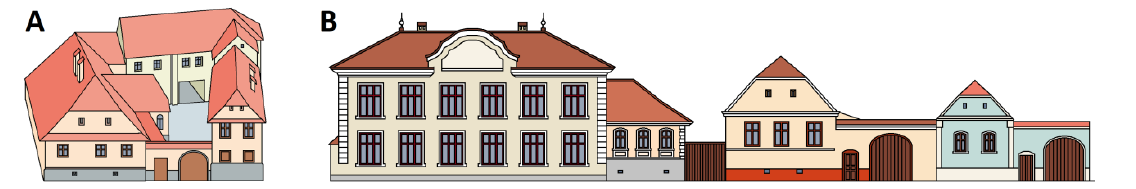
Figure 1: Typical historical buildings in the region of Rupea, A – Bird's-eye view, B – Front view Drawings by MAROȘI Zoltan,